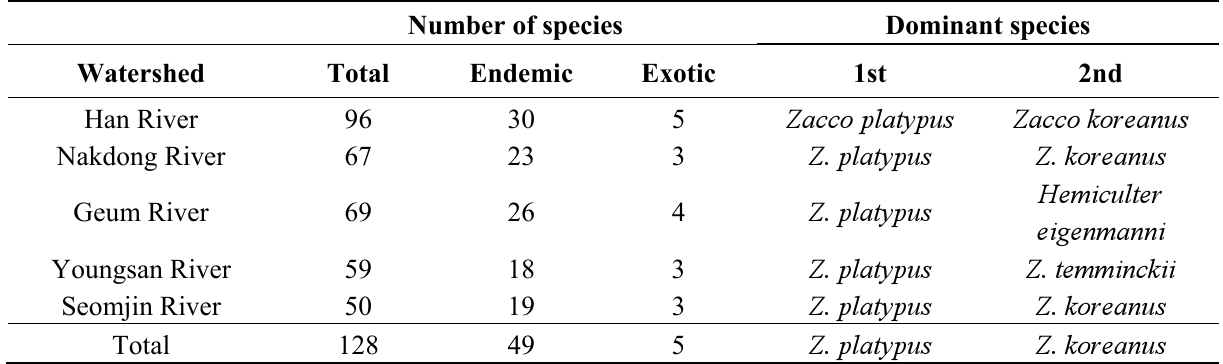
Table 2. Fish assemblage characteristics for different watersheds. Number of species Dominant species